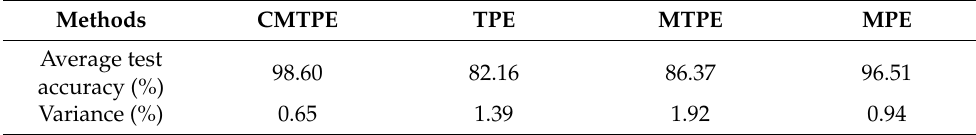
Table 2. Average test accuracy and variance of the four methods.